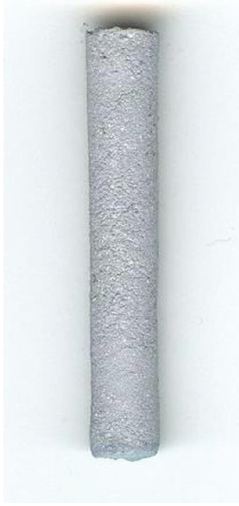
Figure 3: Photograph of a sintered 30 wt.% ceramic content nickel- alumina